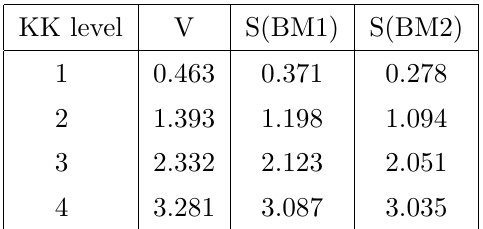
Table 1 . Masses of the four lightest gauge and scalar KK states in units of R (cid:0) 1 for the two BM points considered in the